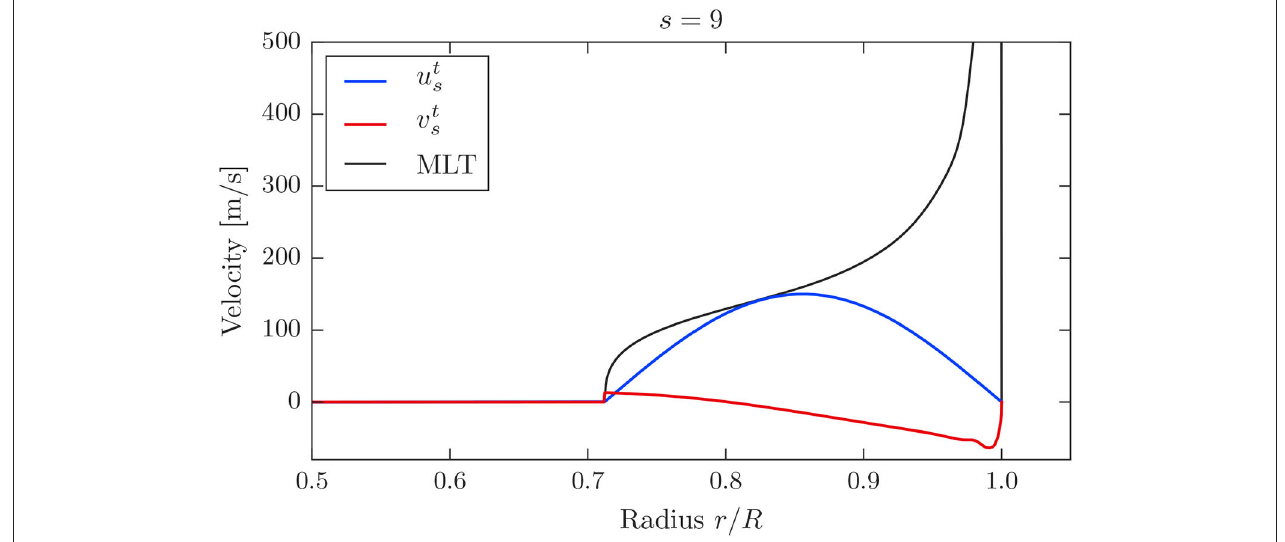
9) as a function of stellar radius. The MLT velocity profile of the stellar model is shown =